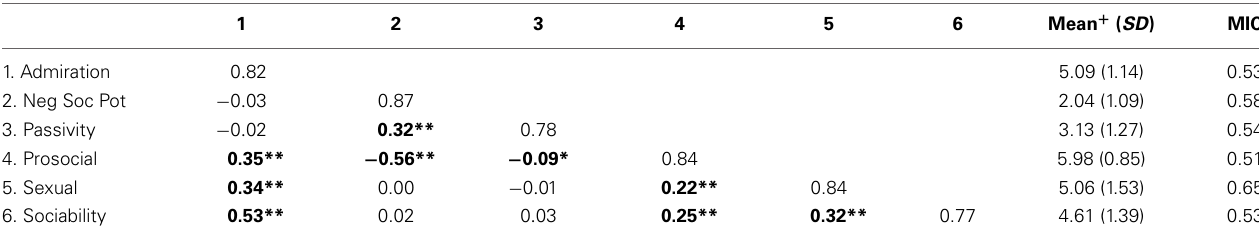
Table 3 | Correlations, descriptives (mean and SD), Cronbach alphas and mean interitem correlations (MIC) for manifest factor totals in Sample 2 ( N =